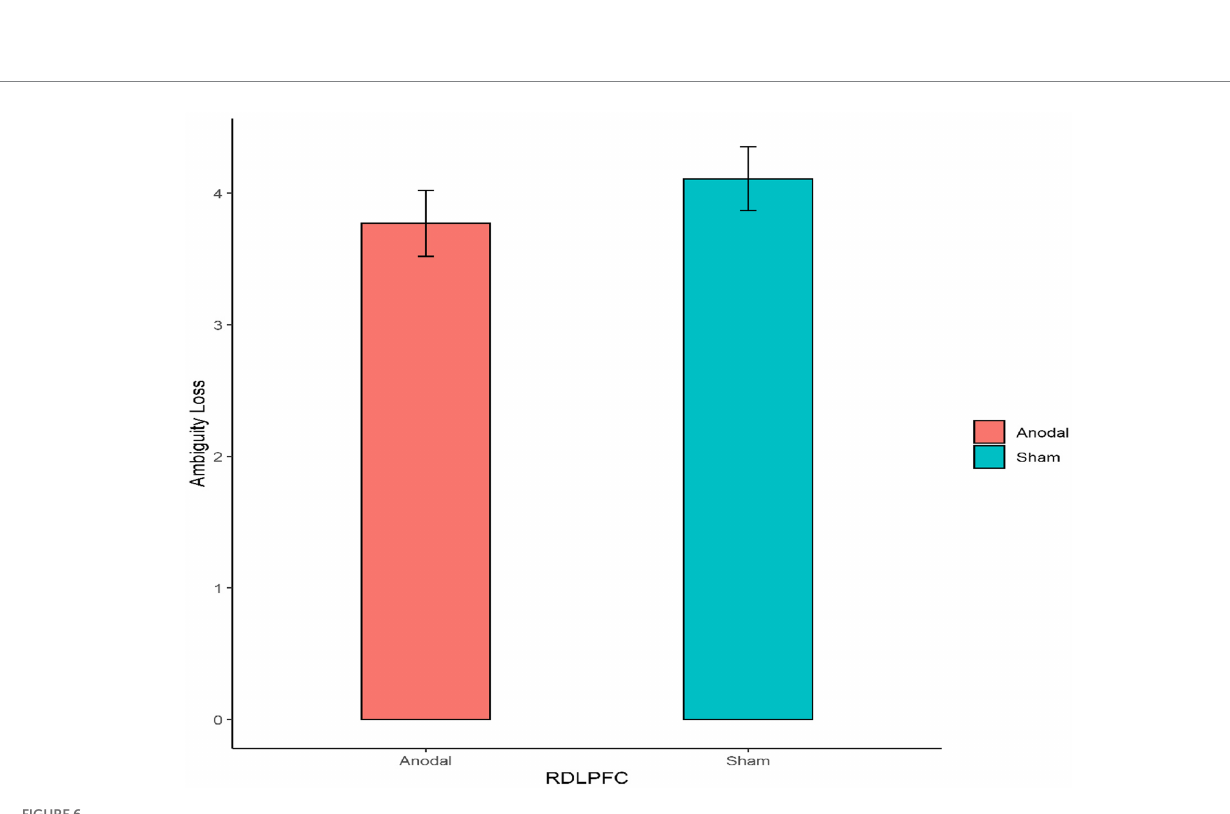
FIGURE 6 The degree of the participants’ attitudes toward ambiguity loss under different right DLPFC stimulation conditions. Error bars represent standard